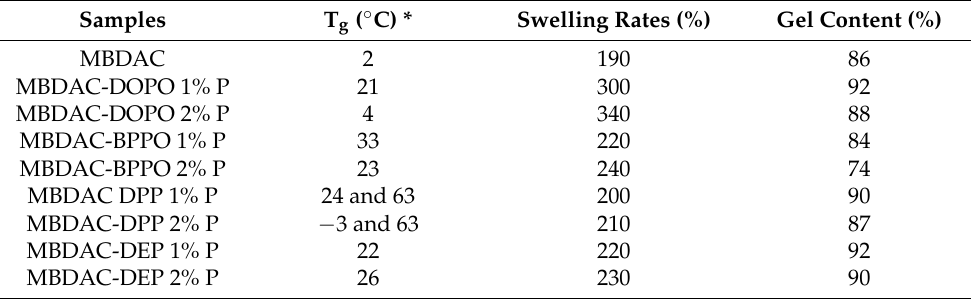
Table 1. DSC, Swelling rate and Gel content analyses of all the PHU thermosets. Samples T g ( ◦ C)